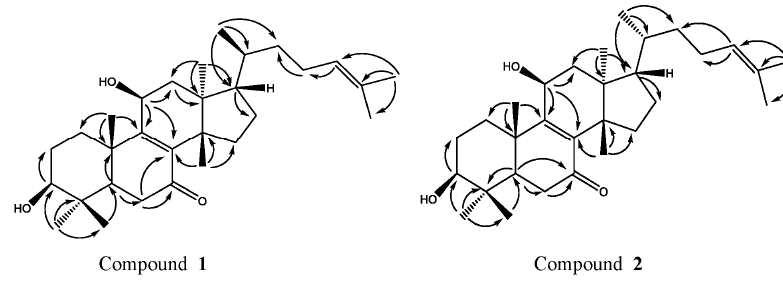
Figure 3. Key HMBC correlations for 1 and 2 .